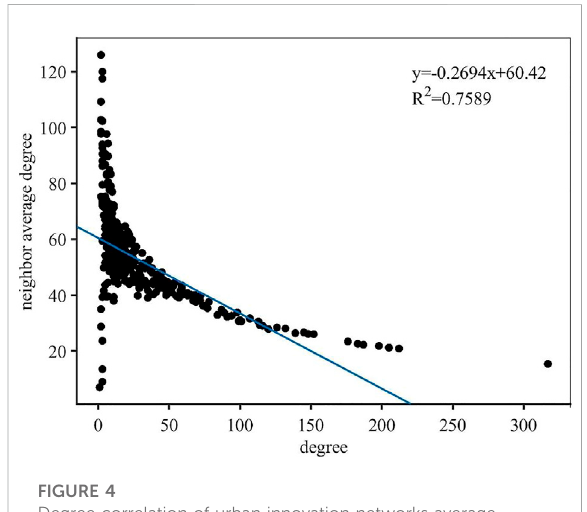
Degree correlation of urban innovation networks average from 2017 to 2019.